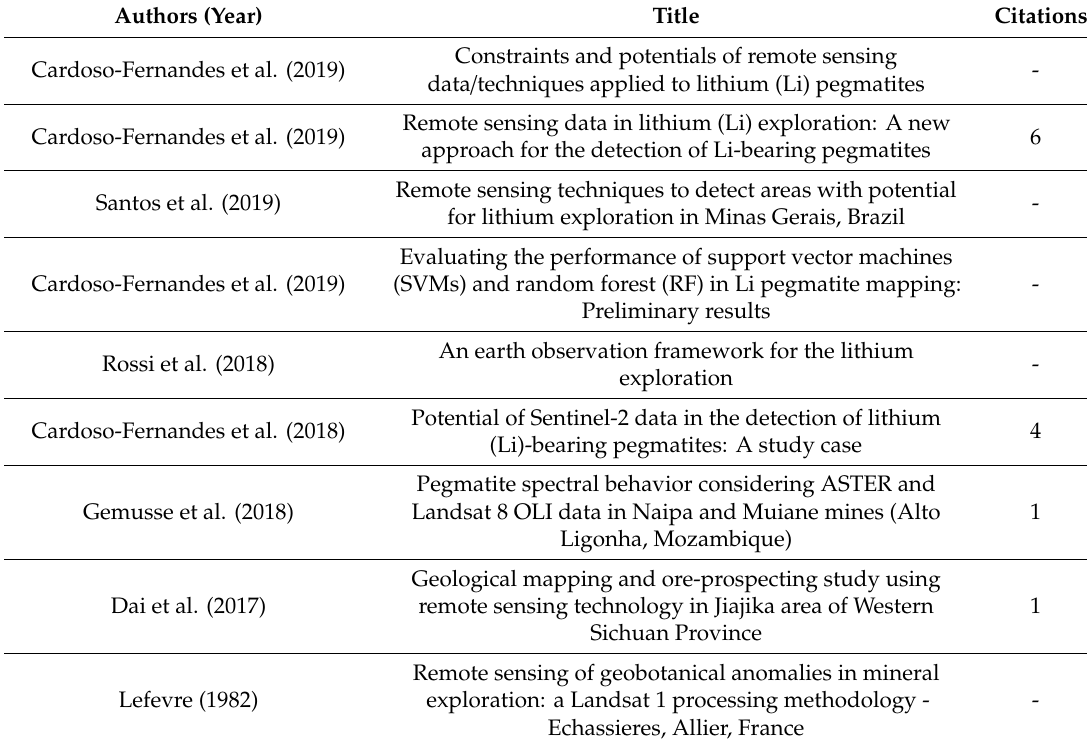
Table 1. SCOPUS search results concerning publications related to Li exploration using remote sensing data and